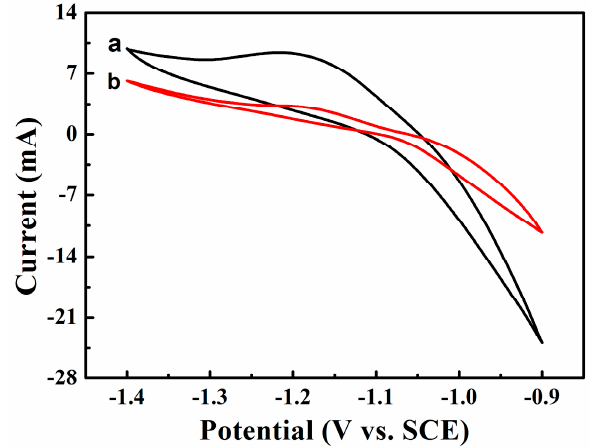
Figure 3. CV of the zinc electrode in the aqueous electrolyte containing different dicarboxylates (a: disodium malonate; and b: disodium succinate).